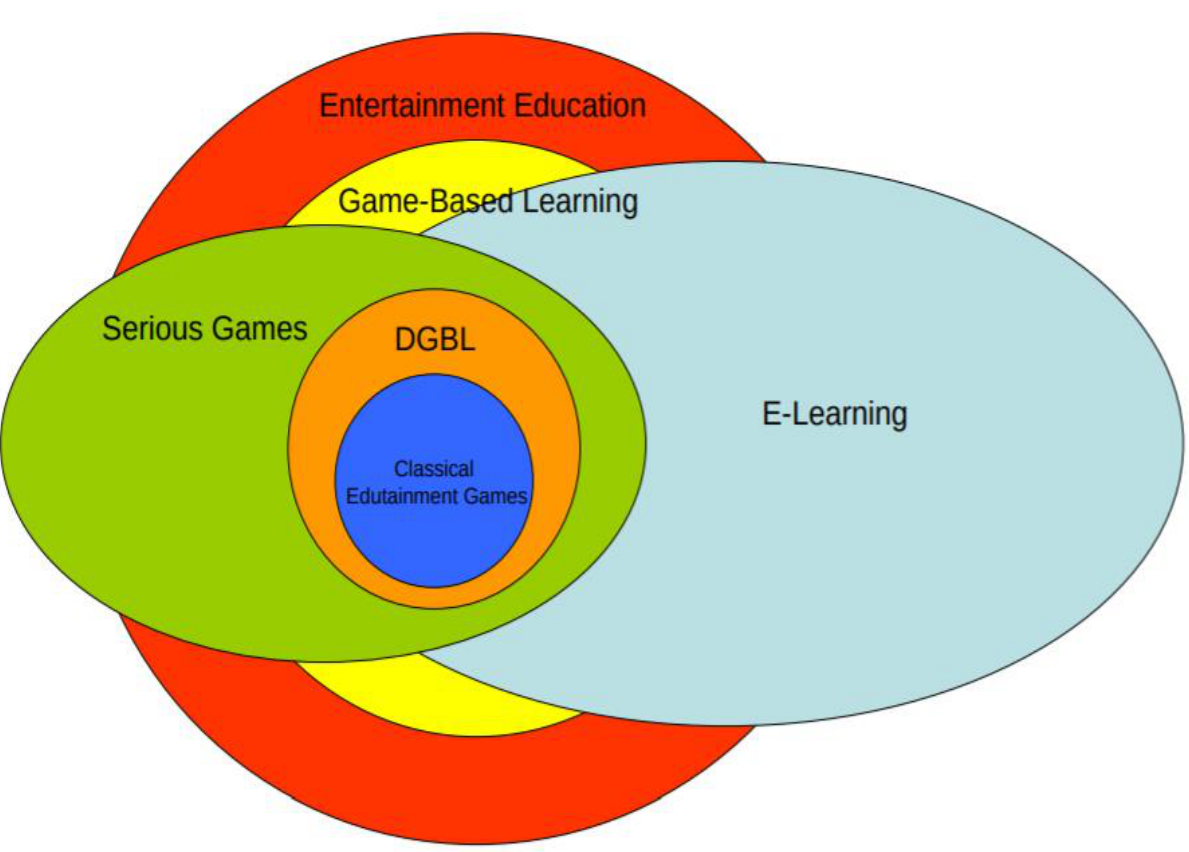
Figure 1. The original caption was, “The relations between serious games and similar educational concepts” (from [2]). While this diagram depicts the overlaps between numerous Games in Learning fields, it fails to readily provide any discrete information as to the nature of these